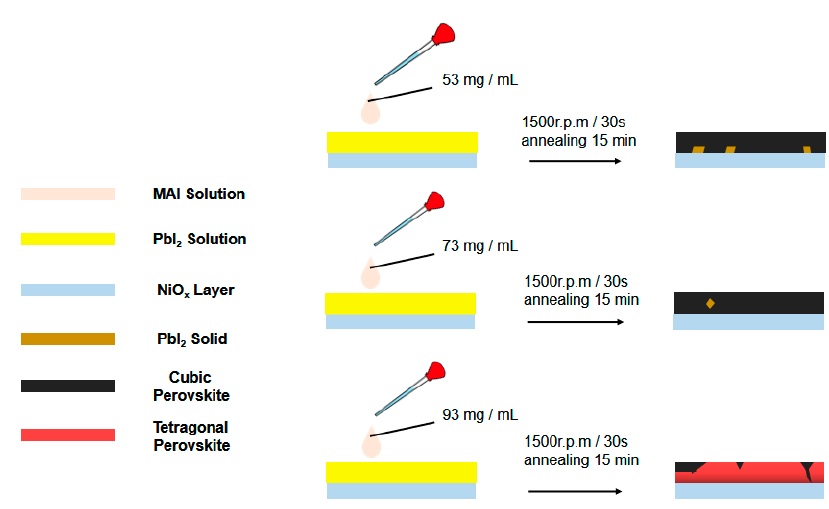
Figure 7. Evolution schematic diagram of organic–inorganic hybrid perovskite structure with different concentrations of MAI precursor solution.